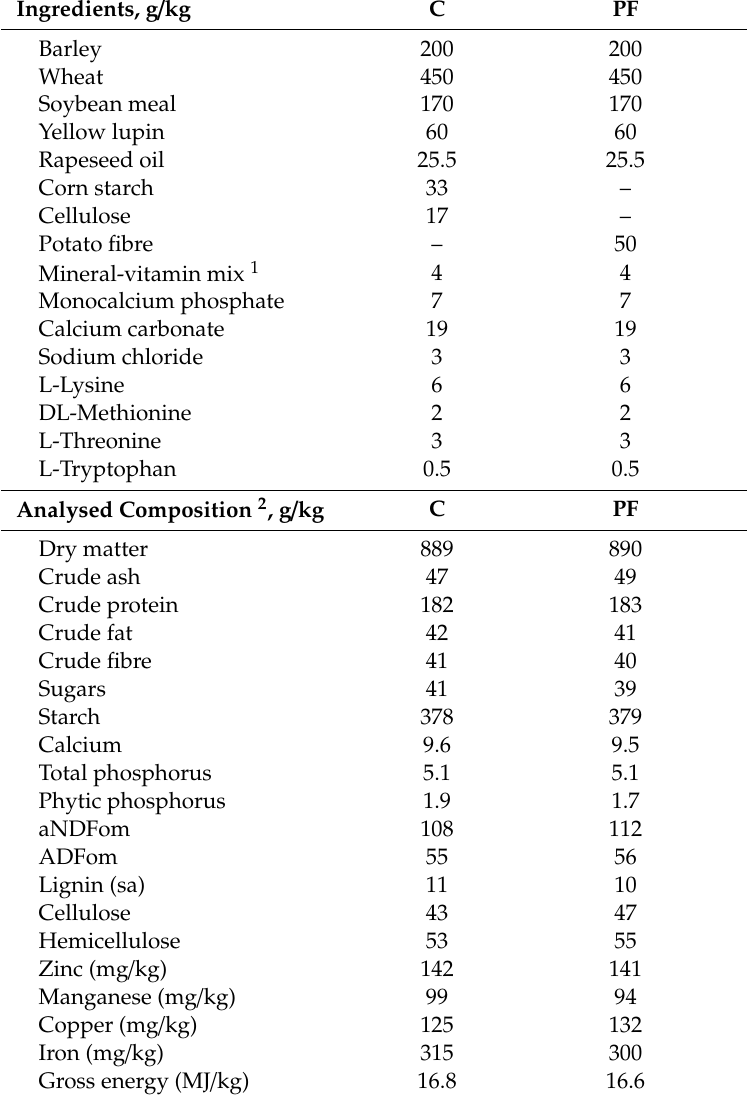
Table 1. Ingredients and chemical composition of the cereal-based diets (g /